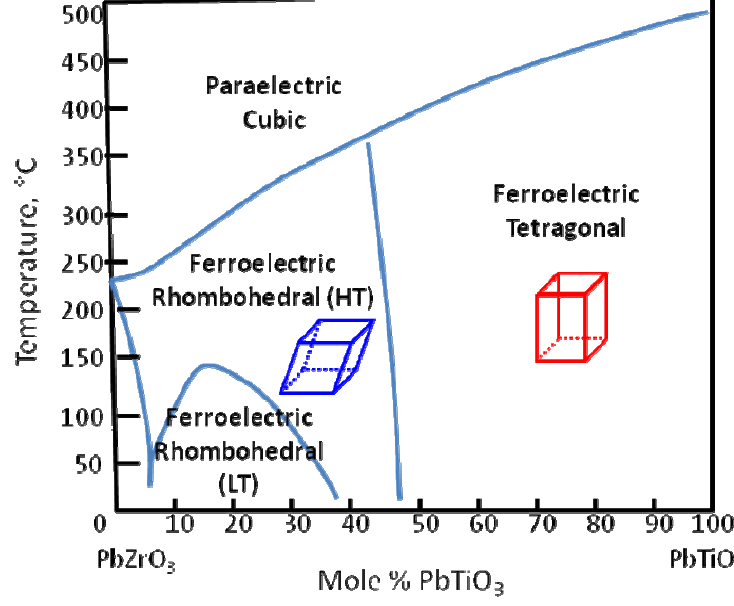
Figure 1. Morphotropic phase boundary in PZT, reproduced from Jaffe et al.